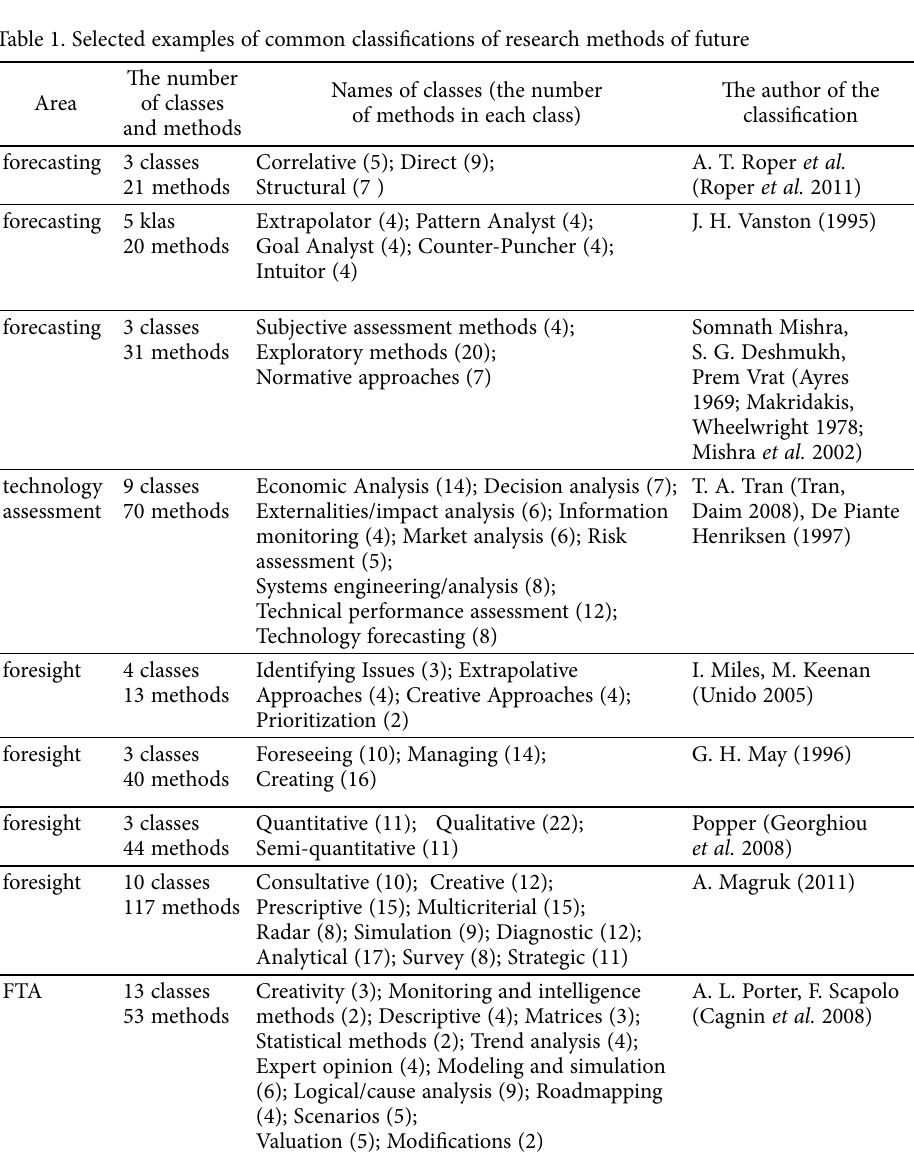
Table 1. Selected examples of common classifications of research methods of